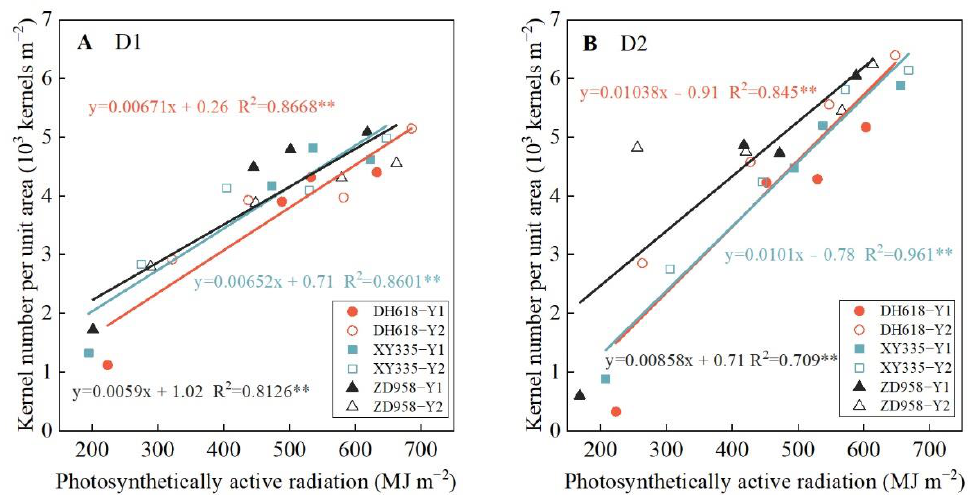
Figure 2. Relationships between kernel number per unit area and photosynthetically active radia- tion from the silking to maturity stages of three maize cultivars in 2019 (Y1) and 2020 (Y2). Planting densities: D1, 7.5 × 10 4 plants ha − 1 ( A ) and D2, 12 × 10 4 plants ha − 1 ( B ). See Figure 1 for cultivar names. **, p ≤ 0.01.